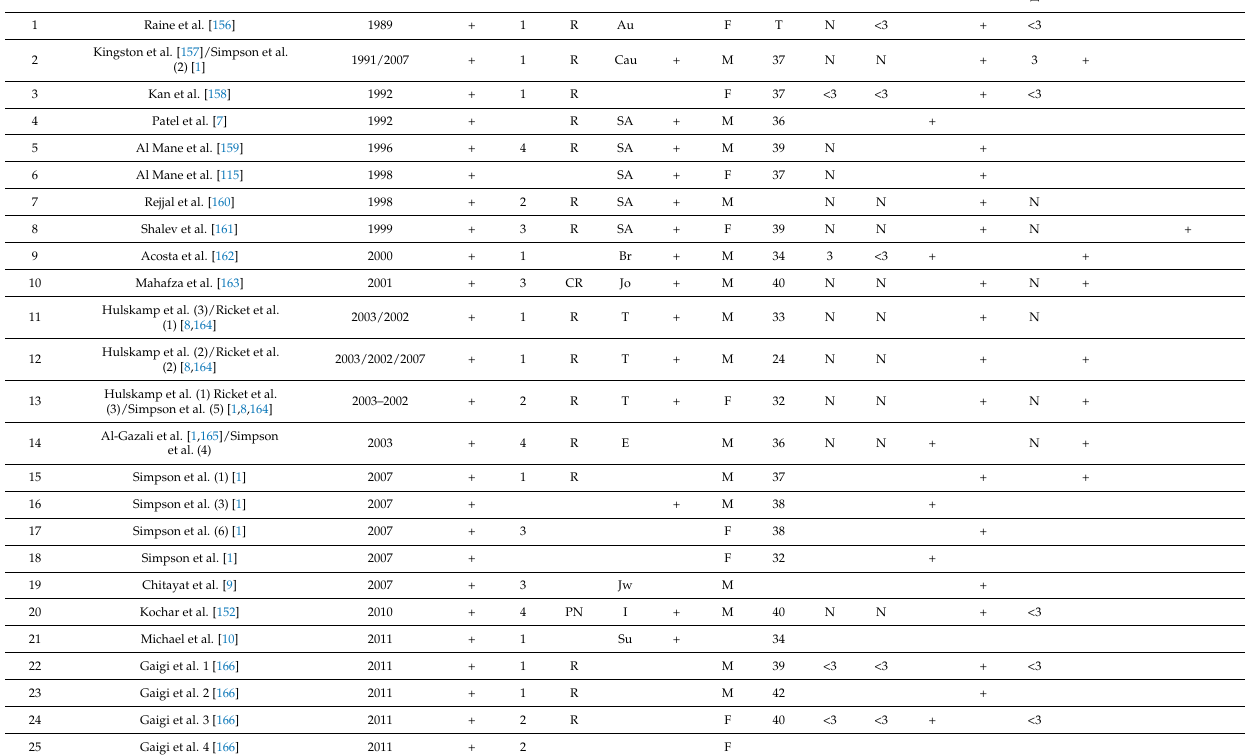
Gaigietal. 3[166] Gaigietal.